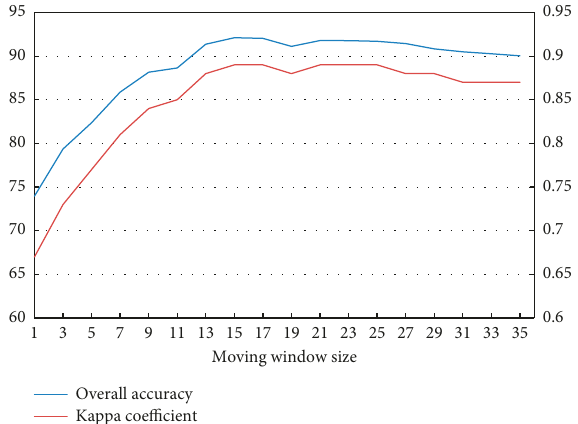
Figure 9: Overall accuracy and kappa coefficient on different